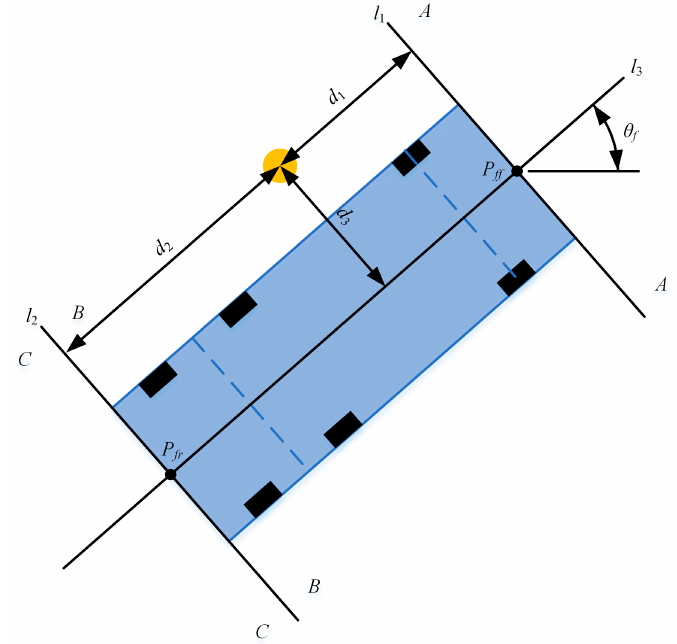
Figure 5. The obstacle avoidance model of the tractor.